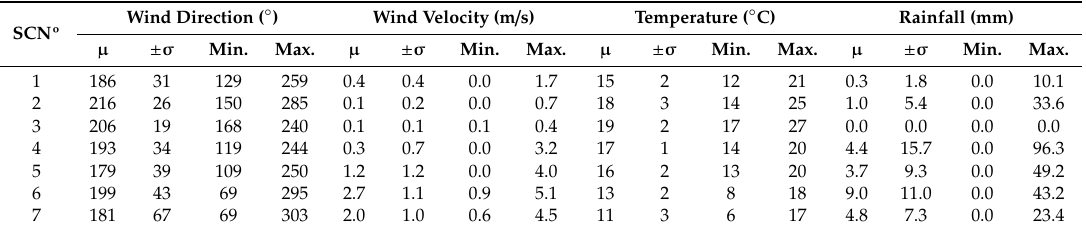
Table 3. Data on the meteorological characteristics verified during the sampling campaigns.